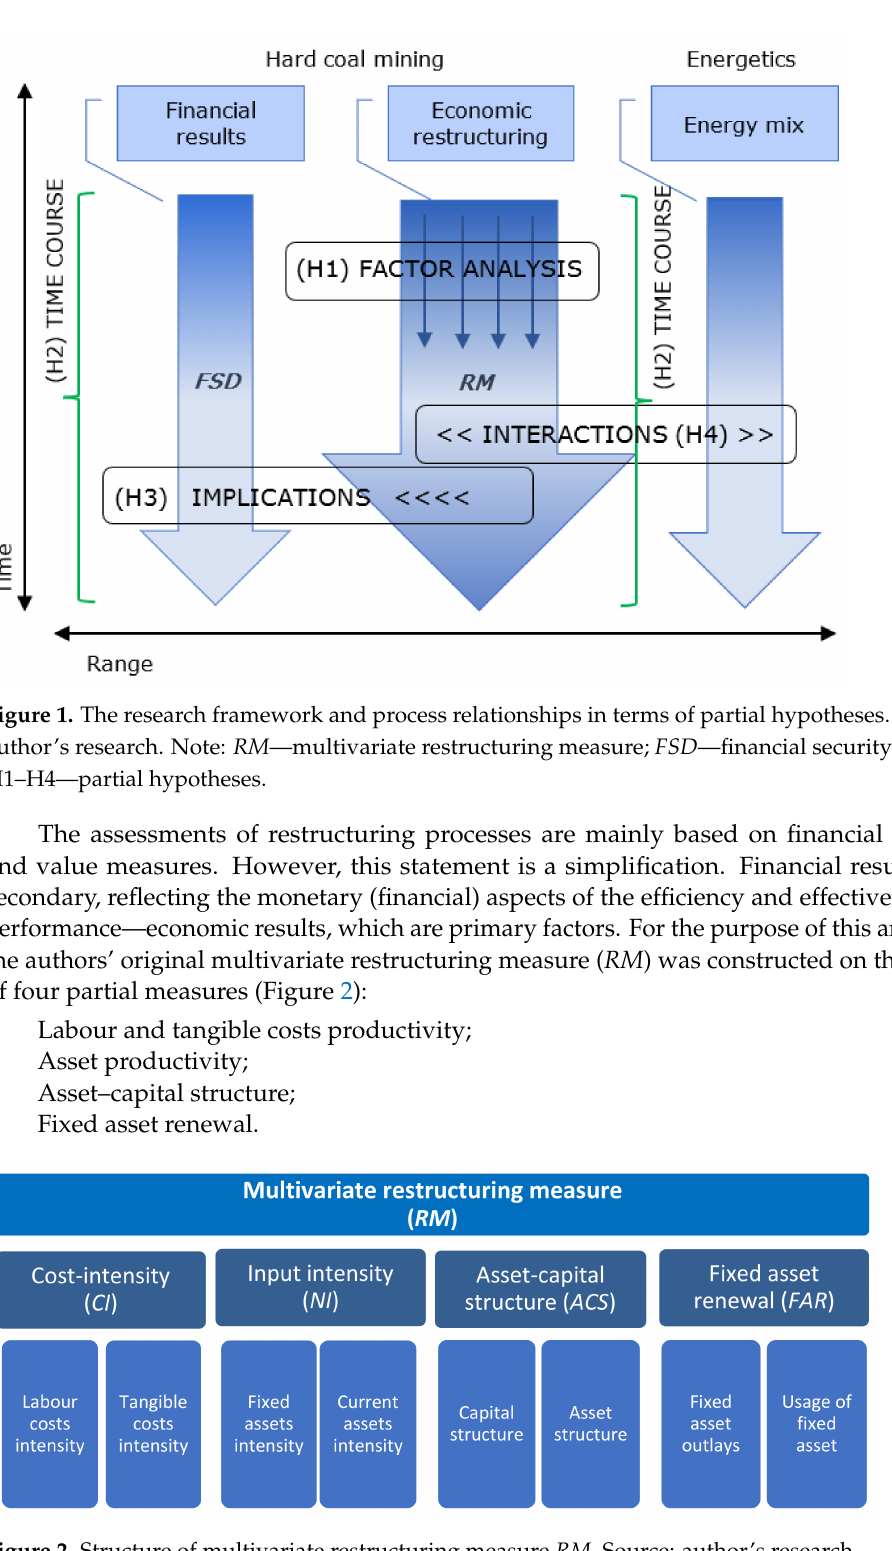
Figure 2. Structure of multivariate restructuring measure RM . Source: author’s